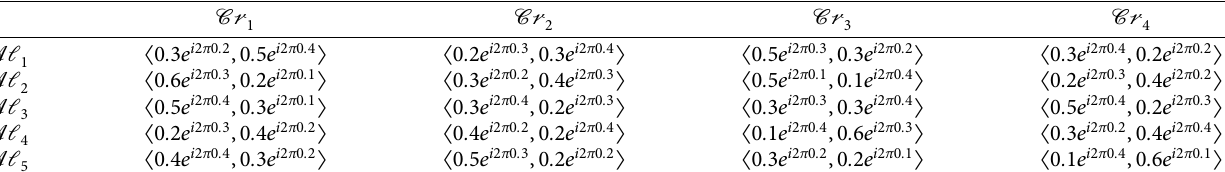
Table 2: Complex intuitionistic fuzzy decision matrix Ὤ ( 2 ) � [ L ( 2 ) Cr 1